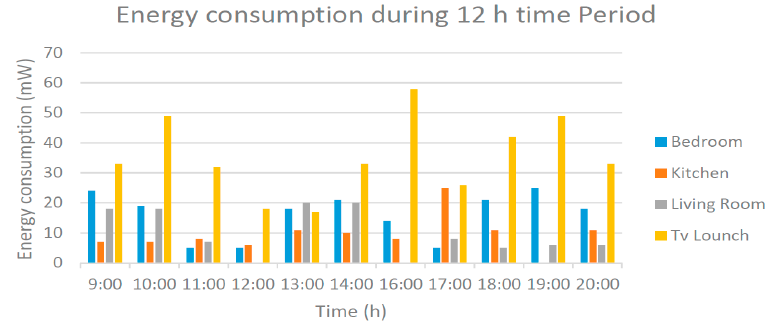
Figure 12. Energy consumption while the sensors operated in 50% and 100% duty cycle.